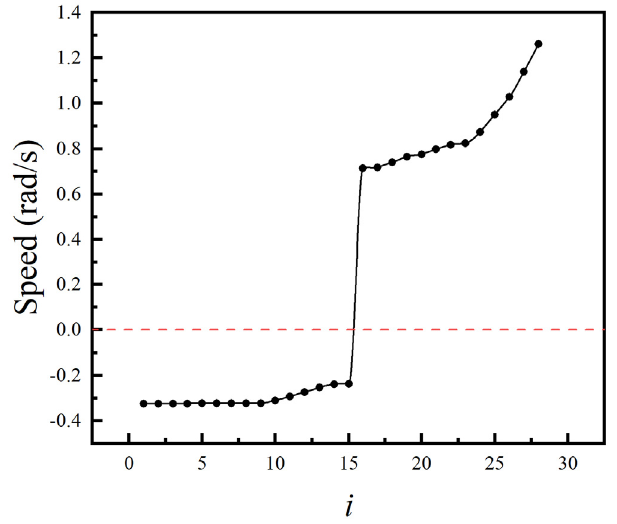
Fig. 17. Relative speed at different positions of the shaft at 124 Hz.